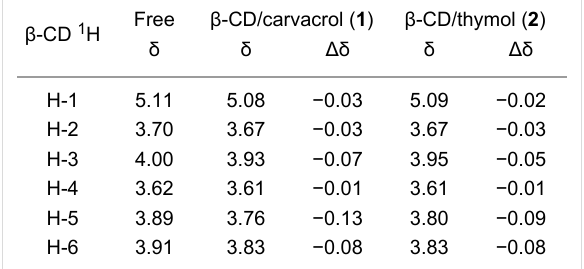
Table 3: Diffusion coefficients ( D , 10 − 10 m 2 /s) and chemical shifts ( δ , ppm) of carvacrol ( 1 ) protons in the presence of different β -CD concentrations.